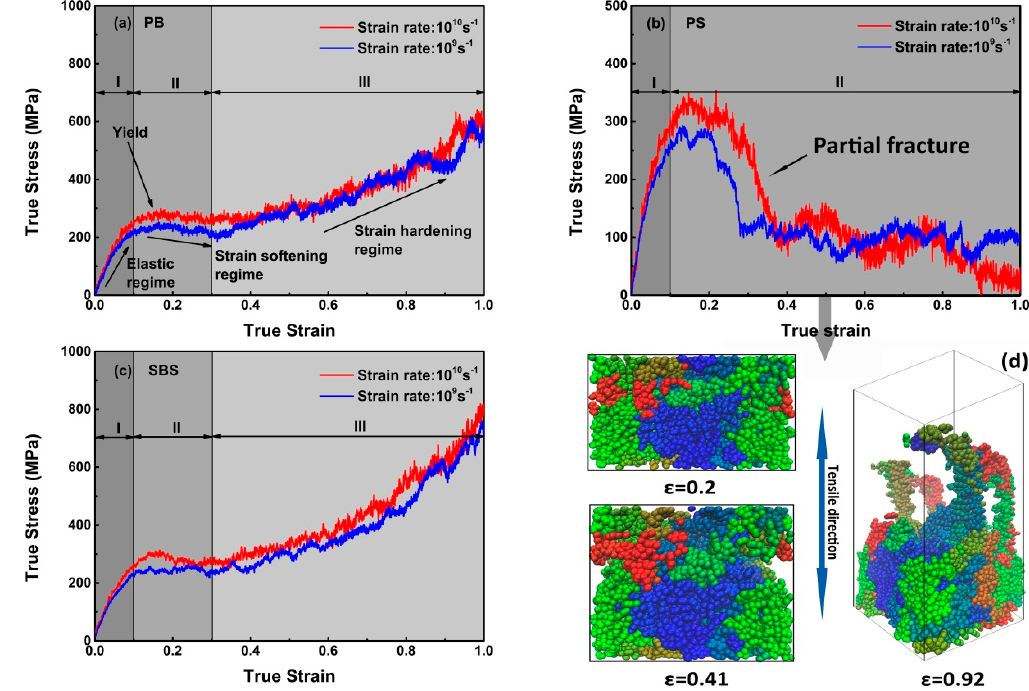
Figure 5. Stress–strain response of the polymer cell under uniaxial tension with strain rates of (cid:2013)(cid:4662) = 10 10 s − 1 and 10 9 s − 1 at 100 K. ( a ) PB; ( b ) PS; ( c ) SBS, respectively. The snapshots in ( d ) are obtained from PS system with different strains ( ε ). The PS chains are in different colors.